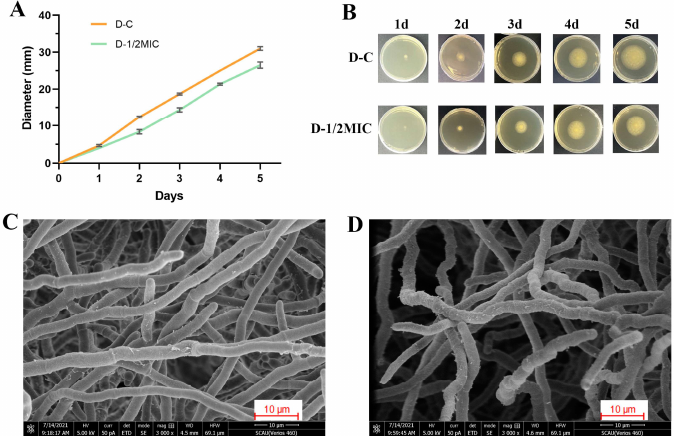
Figure 4. Effect of 2−CDs on the growth and morphology of P. italicum . ( A , B ) Effect of 2−CDs on the growth of P. italicum . SEM images of P. italicum mycelia under different cultivation conditions. ( C ) D−C: normal P. italicum of the control group (96 h); ( D ) D−2−CDs: P. italicum after treatment with 2.8 μg/mL 2−CDs (96 h).